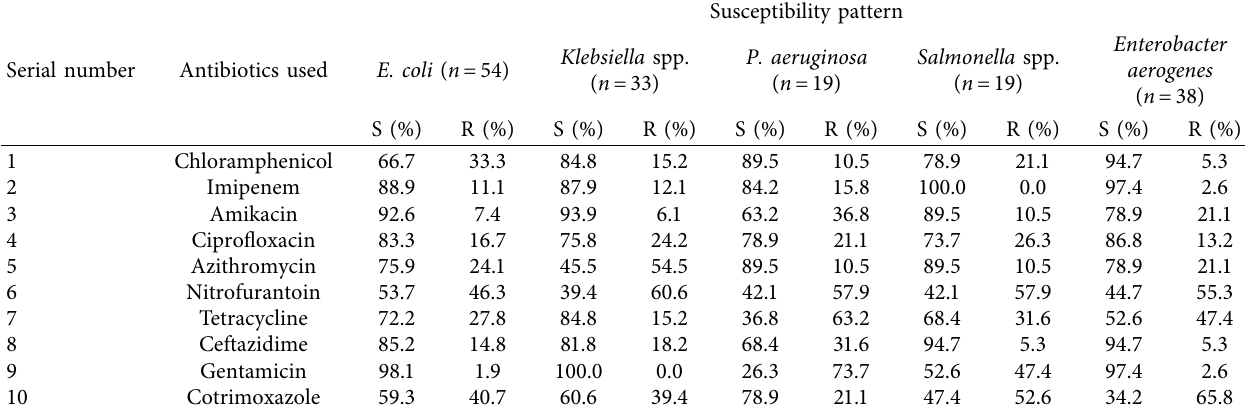
Table 5: Antibiotic susceptibility pattern of Gram-negative isolates.